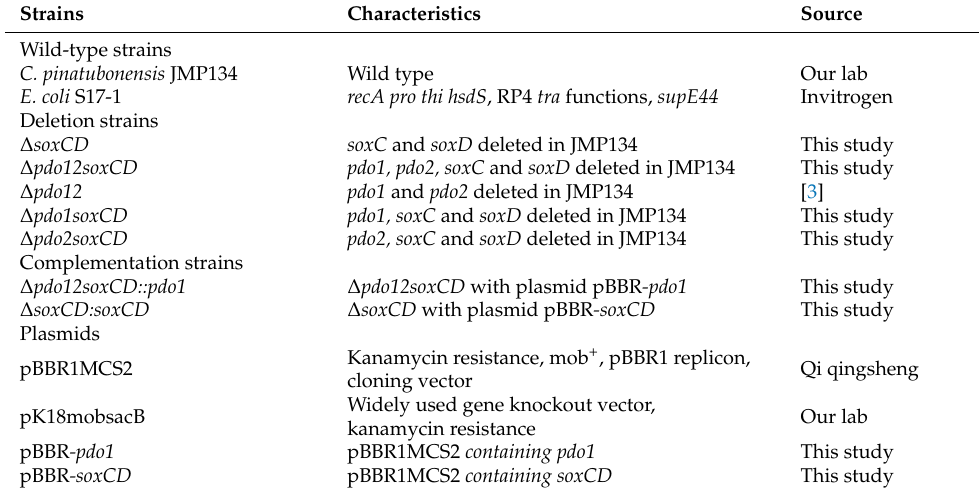
Table 1. Strains and plasmids used in this